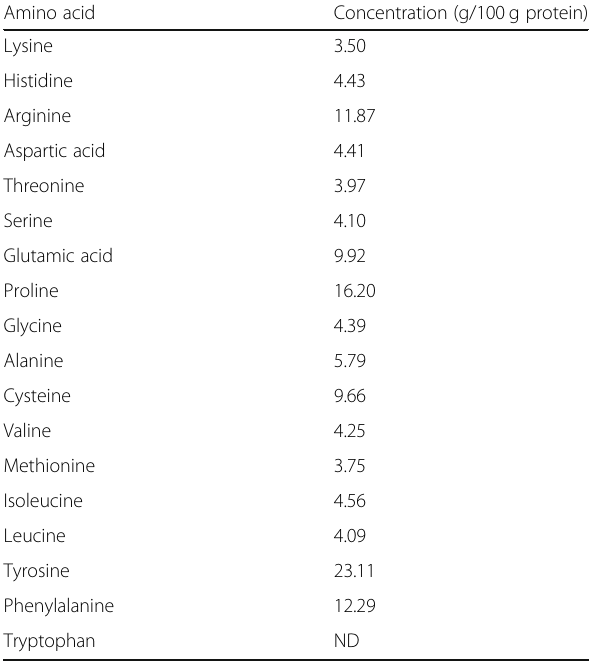
Table 1 Amino acid composition of the storage protein of Dioscorea bulbifera Amino